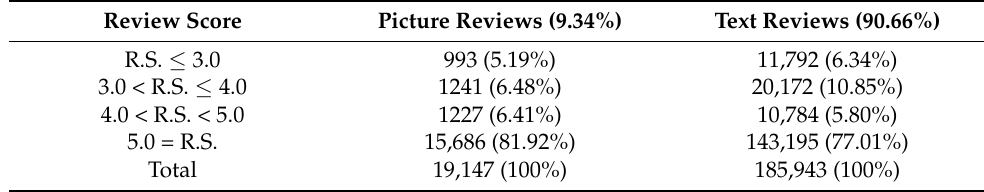
Table 5. Distribution of different types of reviews.